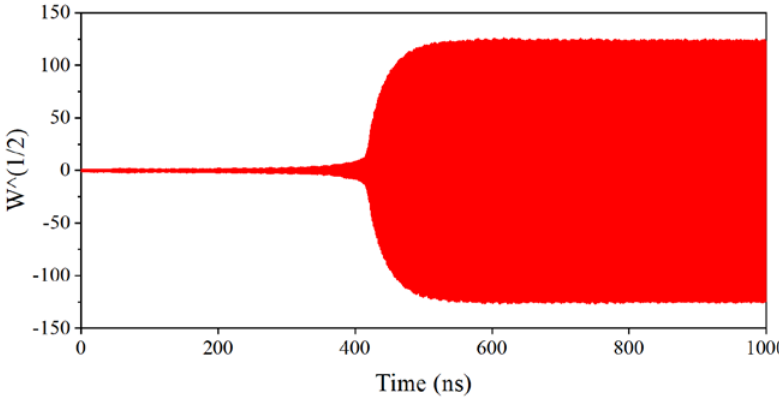
Figure 6. 12 − vanes 2.45 GHz magnetron output power oscillation curve.